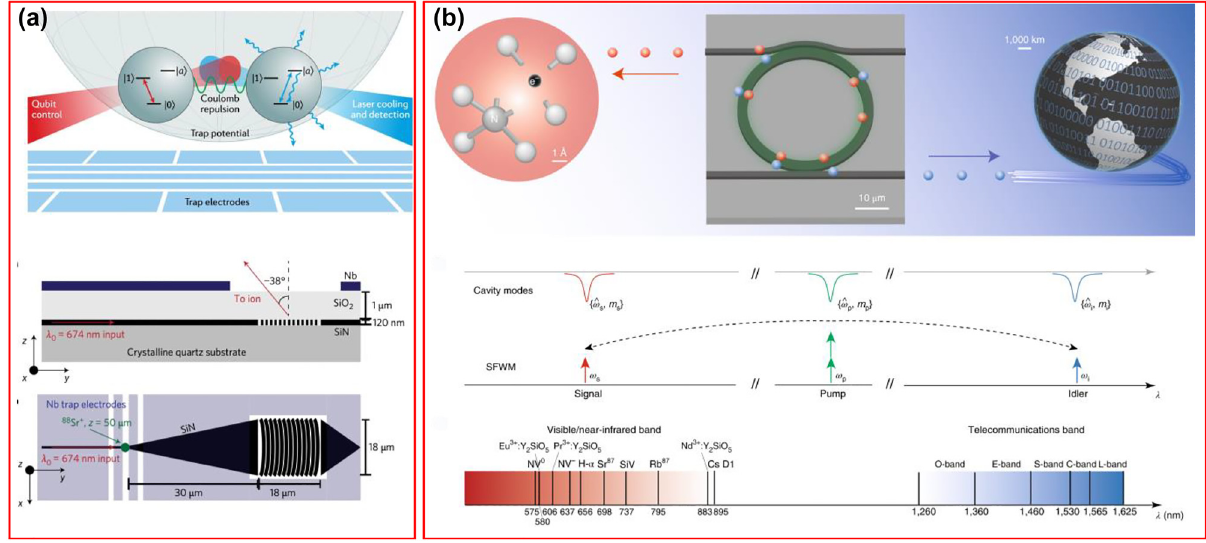
Figure 8: Integrated quantum technologies. (a) Quantum computing with trapped ions [281]; focusing grating schematic to deliver 674 nm light to Sr + ions [282]. (b) Chip-integrated visible–telecom entangled photon pair source for quantum communication [284]. [(a) Reproduced with permission from reference [281]. Copyright © 2021, nature publishing group; reproduced with permission from reference [282]. Copyright © 2016,